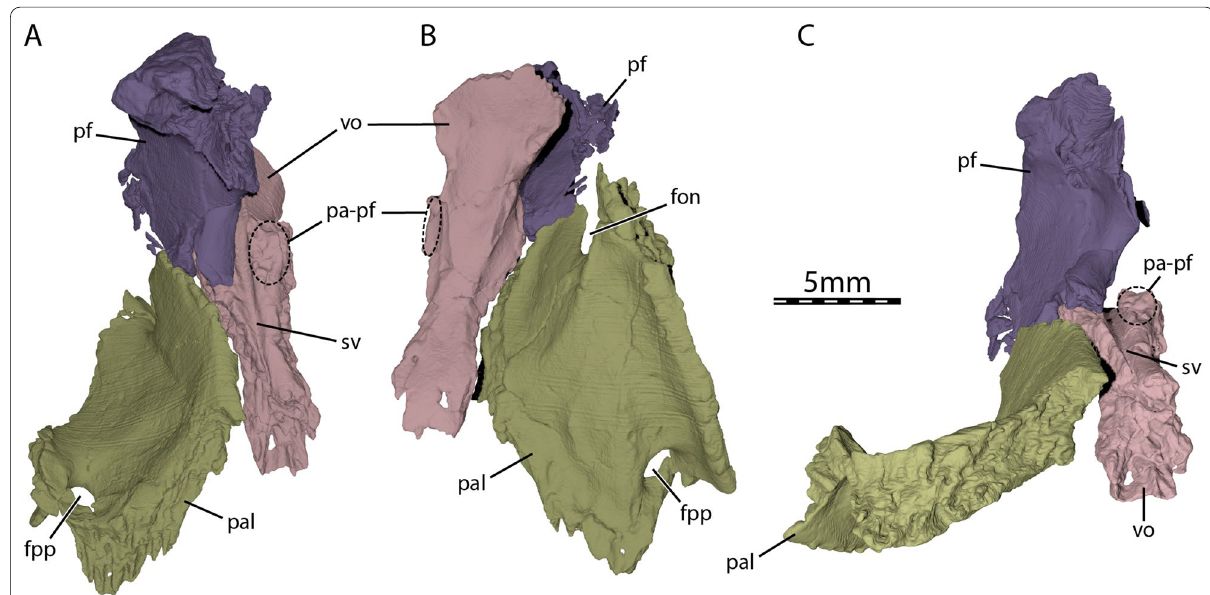
Fig. 4 Three-dimensional renderings of the palatal region of UCM 53971. A Dorsal view, B ventral view, and C posterior view. fon foramen orbito-nasale, fpp foramen palatinum posterius, pal palatine, pa-pf process for articulation with the prefrontal, pf prefrontal, sv sulcus vomeri, vo